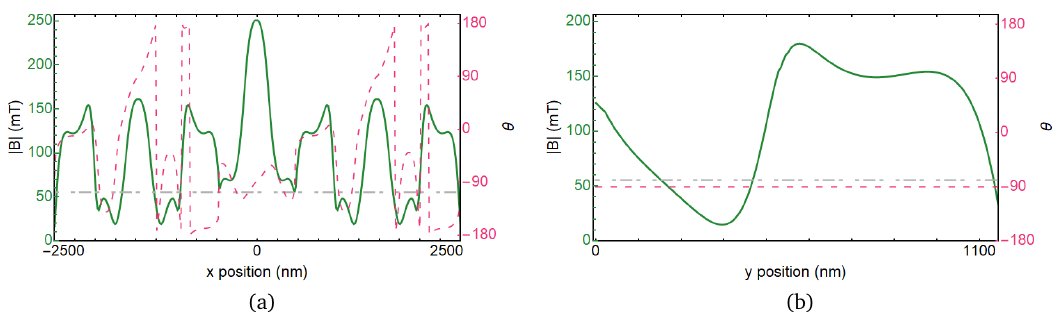
Figure 14: (a) Magnetic field of top wire for T-Junction. (b) Magnetic field in the T-Junction leg (vertical segment of nanowire). There is an external field of 40mT applied in positive y-direction.